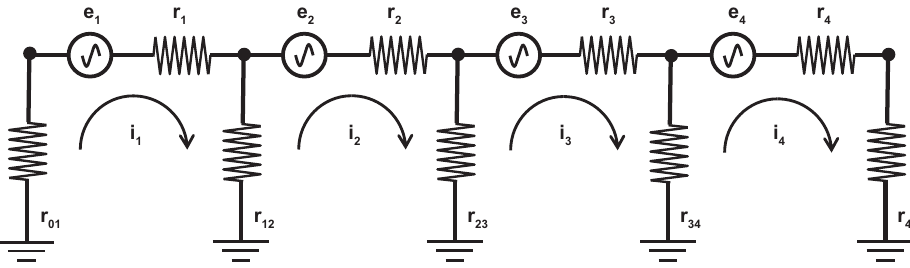
Fig. 1. Single-phase diagram of a power network illustrating mesh resistances, r , induced emfs, e and loop currents,